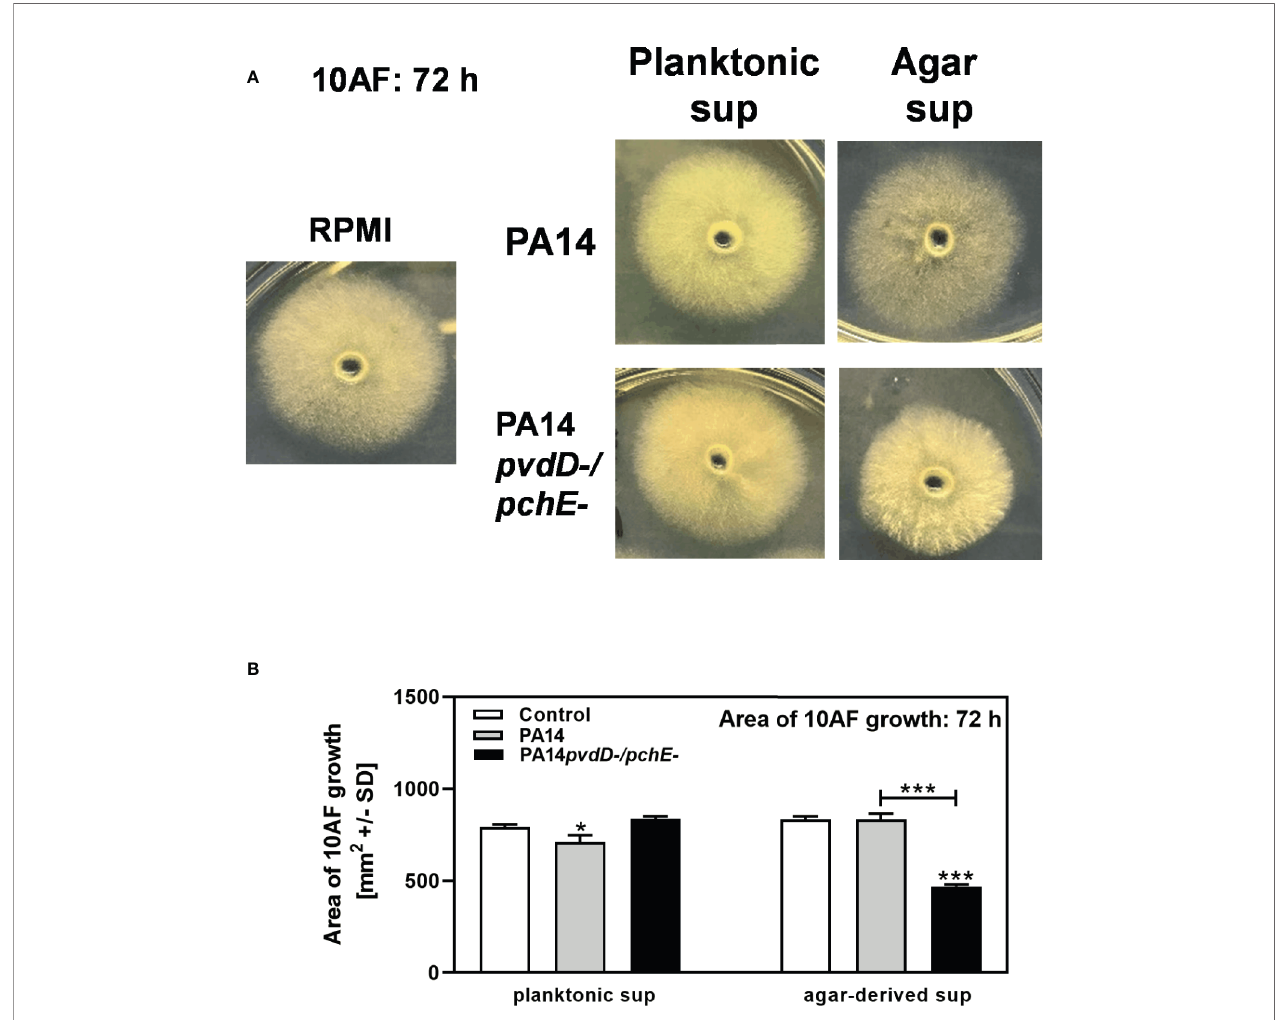
FIGURE 2 | Increased antifungal effects of PA14 pvdD-/pchE- can be transferred by agar-derived fi ltrates, but not by planktonic fi ltrates. (A, B) Five-millimeter wells in RPMI agar were inoculated with a total of 150 µl of RPMI, agar, or planktonic bacterial fi ltrate. Ten microliters of RPMI agar was allowed to solidify in each well, and 10 µl of A. fumigatus (10 5 conidia/ml) was inoculated into each well. Plates were incubated at 37°C for 72 h. The mean diameters of colonies per isolate and treatment were as follows: for RPMI, 32.2 mm; for PA14/planktonic fi ltrate, 30.7 mm; for PA14 pvdD -/ pchE -/planktonic fi ltrate, 33.2 mm; for PA14/agar fi ltrate, 33.2 mm; for PA14 pvdD -/ pchE -/agar fi ltrate, 25.2 mm. (A) Representative pictures. (B) Areas of A. fumigatus growth were calculated. Comparison: Control vs . all other bars in each group, or as indicated by the ends of the brackets. Statistical analysis, t-test: one, or three asterisks = p ≤ 0.05, and p ≤ 0.001,